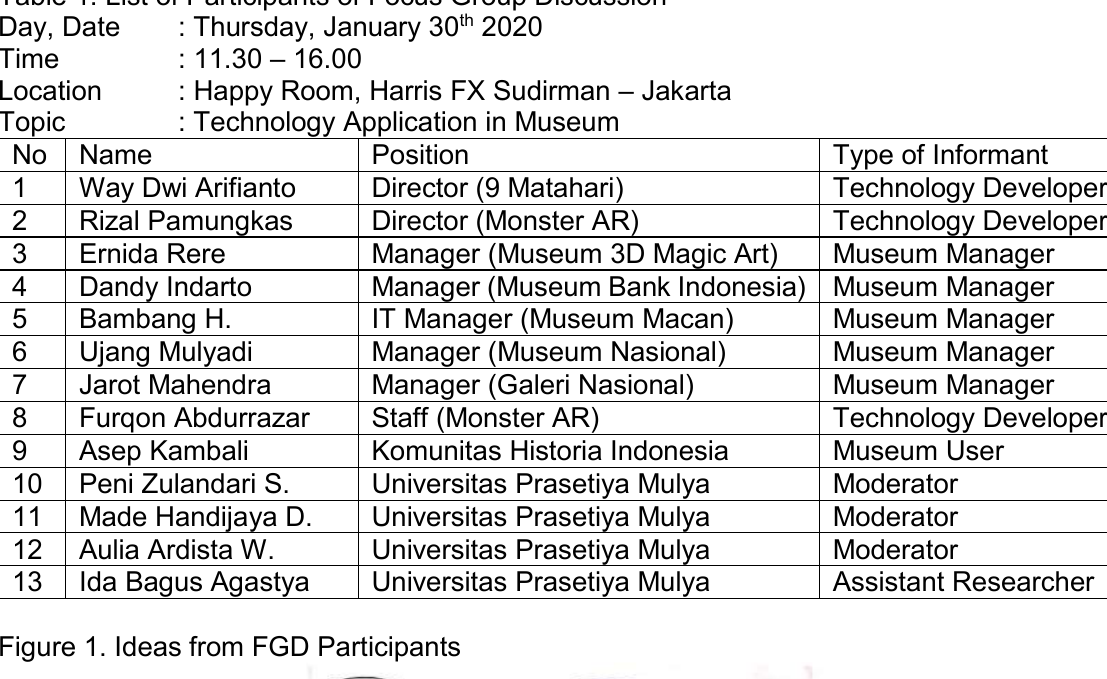
Figure 1. Ideas from FGD